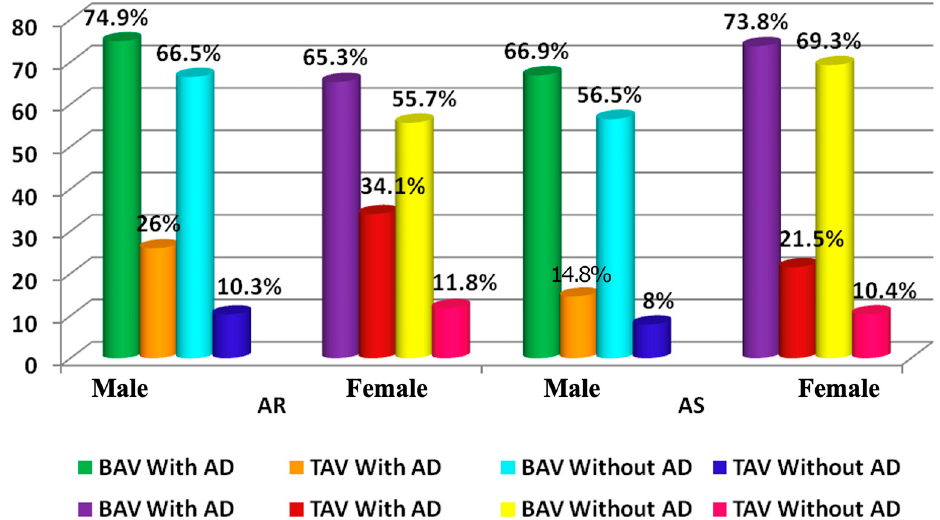
Table 5. Demographic and clinical characteristics of male patients.